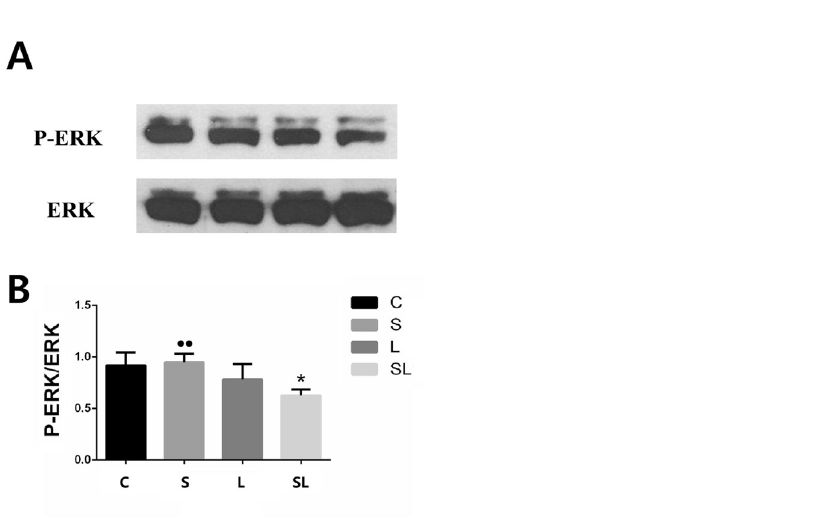
Figure 6. Comparison of the levels of p-ERK and ERK in the hippocampi of the C, S, L and SL groups. ( A ) Expression of four p-ERK and ERK proteins in the C, S, L and SL groups. ( B ) Statistical analysis results of p-ERK/ERK. The data are presented as the means ± SDs.* p < 0.05. •• p < 0.01 compared to the cumulative